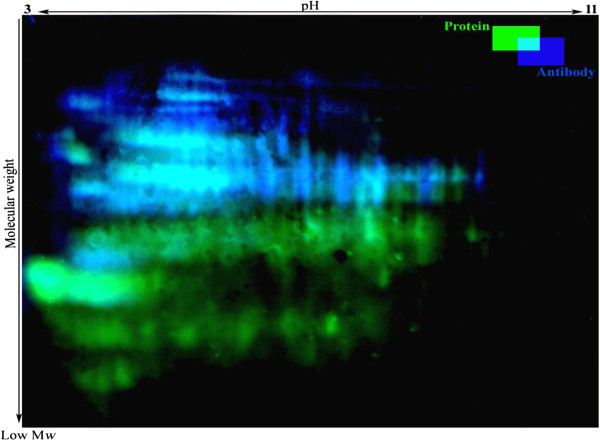
Protein carbonyl patterns of freeze-dried A. senegalensis kept at 35°C for 12 months. Total proteins were stained with Cy3 (green) and were separated by 2D-DiGE. Following transfer to PVDF membrane, the carbonyl groups in proteins were analyzed by immune-detection using a Cy2-coupled assay (blue).